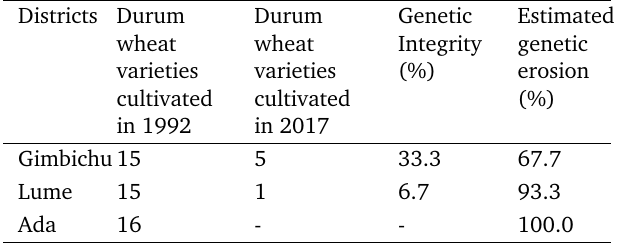
Table 2. Genetic erosion of tetraploid wheat since 1992 in three districts of the central highlands of Ethiopia based on semi-structured interviews with 149 farmers.